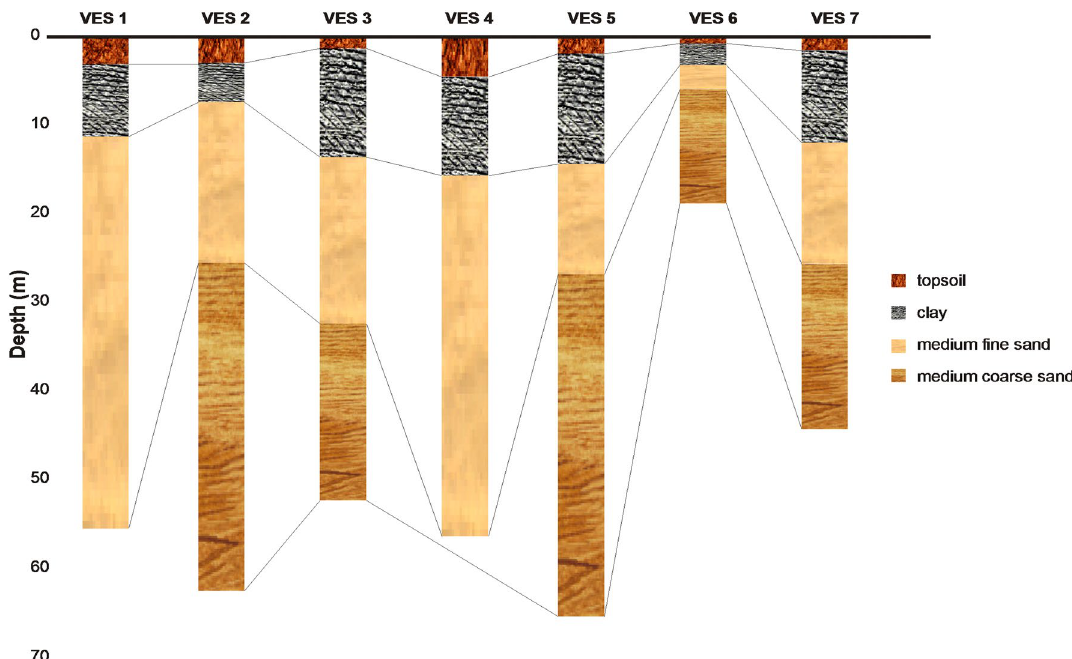
Fig. 6 Interpreted lithology with